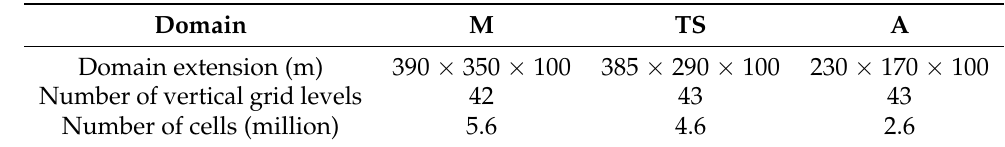
Figure 5. Aerial view zoom of the city of Paris with the specific buildings of interest (red circles). Table 1. Nested domain main